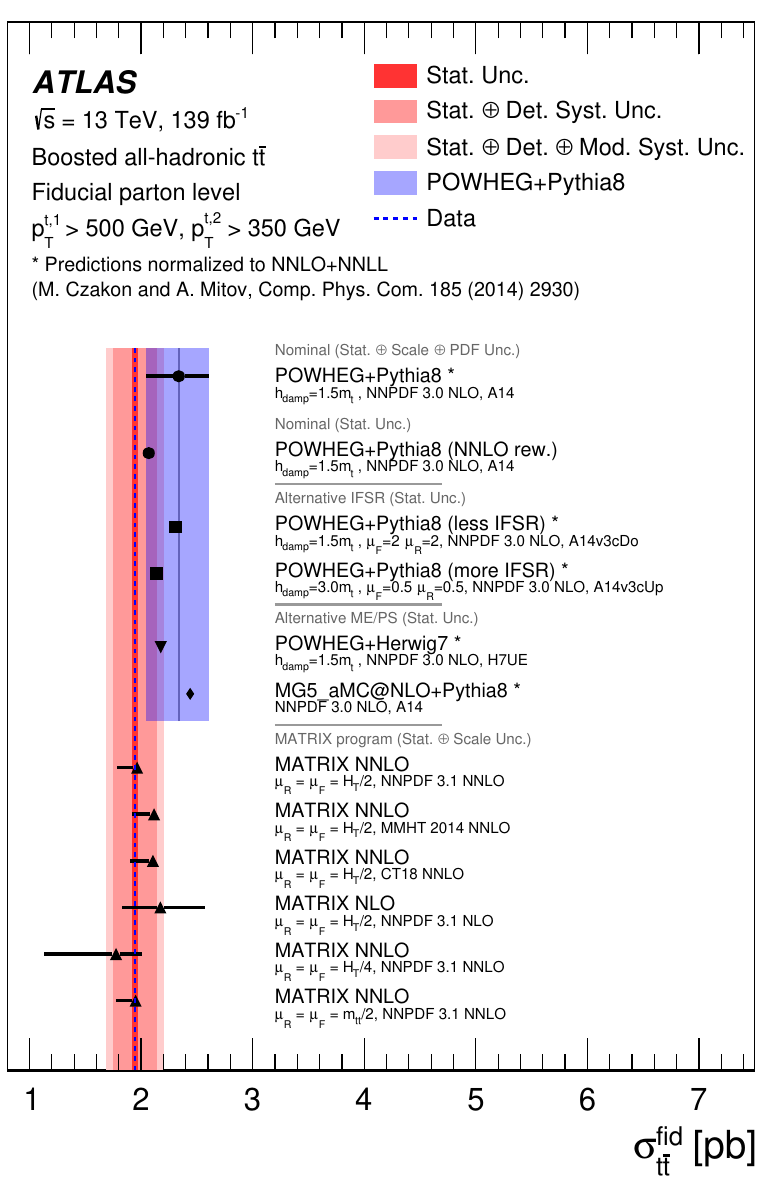
Figure 21 . Comparison of the parton-level fiducial phase-space cross-section with the calcula- tions from several MC generators and the fixed-order NNLO prediction with various PDF sets and dynamical scales obtained using the Matrix program. A correction has been made for the t ¯ t branching fraction to the all-hadronic final state. The shaded (red) bands indicate the sta- tistical, detector, and modelling uncertainties in the measurement. The uncertainty associated with the Powheg+Pythia 8 signal model (blue band) includes the statistical, scale, PDF, and NNLO+NNLL total inclusive prediction uncertainty. Other MC calculations show only the sta- tistical uncertainty of the MC calculation, which is negligible and not visible in the figure. The fixed-order NNLO calculations include the scale uncertainties, which are asymmetric, and the sta- tistical